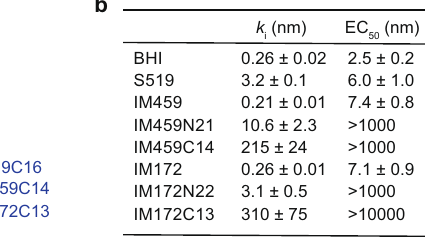
are SEM; n =3 independent replicates. Source data are provided as a Source Data fi le. c The [Site-1]-[Site-2] fusion peptide S961 15 . Individual residues colored green andmauvewithinpanelsaandcarethosethatarepartofthede fi ningmotifsofthe [Site 2]- and [Site 1] peptides, respectively (see Supplementary Fig. 1); residues involved in disul fi de bridge formation are colored in yellow, with the corre- sponding bridge shown as yellow square